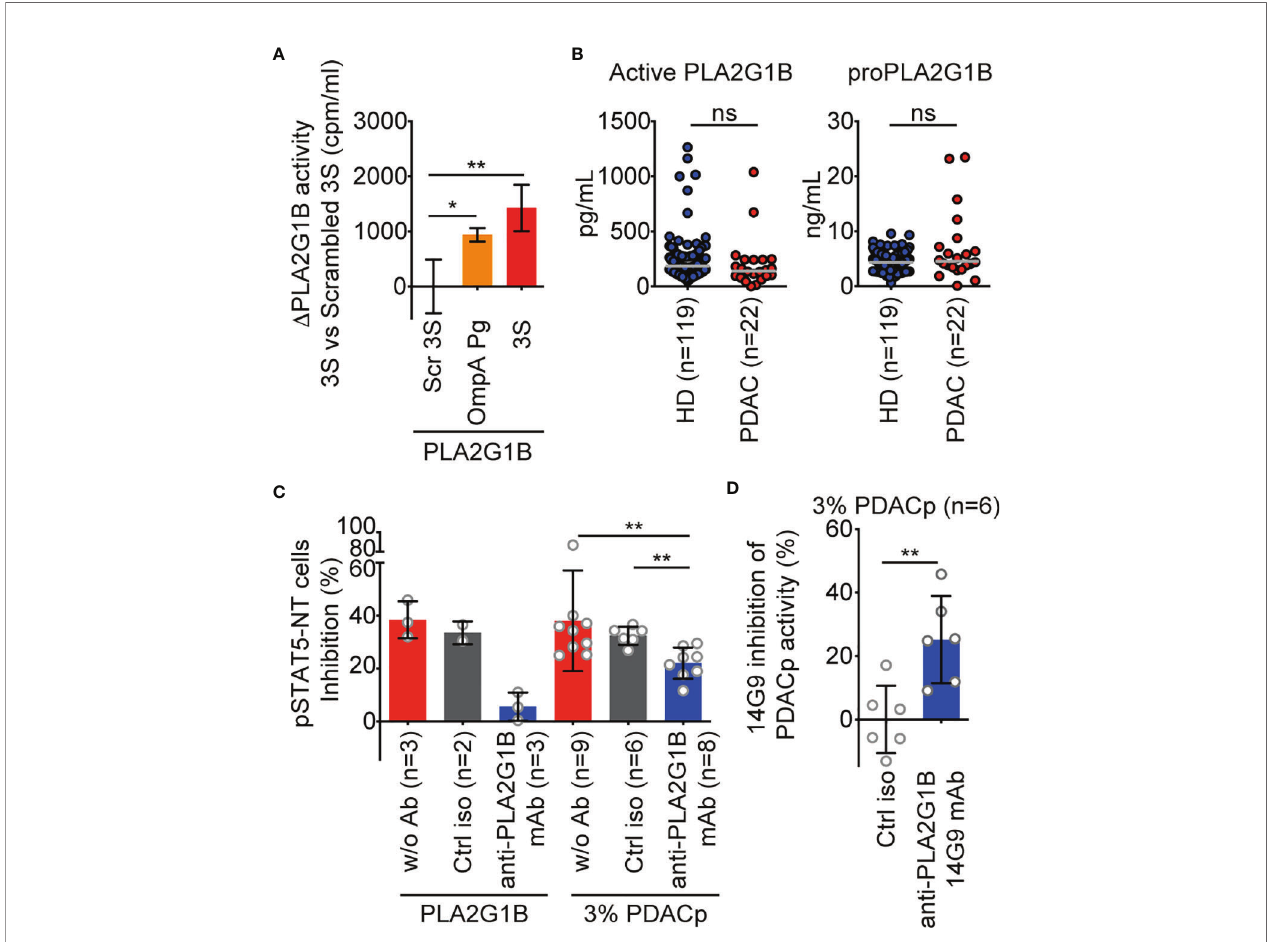
FIGURE 5 | PLA2G1B is involved in PDAC plasma inhibition of the CD4 T-cell pSTAT5-NT response. (A) A 3S-like peptide from P. gingivalis (OmpA Pg) increases PLA2G1B enzymatic activity. [3H]-AA-labeled Jurkat T cells were pretreated with 3S, OmpA Pg or scrambled 3S (Scr 3S) peptides (11µM) for 21 h and incubated alone or with PLA2G1B (200 nM). Results are shown as the mean ± SD of PLA2G1B activity with the 3S or OmpA Pg minus PLA2G1B activity with Scr 3S from one representative experiment of two with similar results. (B) ELISA quanti fi cation of active PLA2G1B and proPLA2G1B in plasma from HD and PDAC donors (the median is shown). (C) Anti-PLA2G1B mAb inhibits PLA2G1B activity in PDAC plasma. HD CD4 T cells from three donors were treated with PLA2G1B (75 nM), 3% of PDAC plasma (PDACp) alone (w/o Ab, n = 9 plasma samples), with control isotype (ctrl iso, 667 nM, n = 6 plasma samples) or anti-PLA2G1B mAb (14G9, 667 nM, n = 8 plasma samples) and the pSTAT5-NT cell response to IL-7 was analyzed by confocal microscopy. Results are shown as the mean ± SD of percentage of pSTAT5-NT cells inhibition. (D) Heterogeneity of anti-PLA2G1B mAb 14G9 inhibition of PLA2G1B activity in PDAC plasma. Results are shown as the mean ± SD of the percentage of inhibition of PDACp activity from six patients on pSTAT5-NT by 14G9 relative to that of control isotype-treated plasma. * p < 0.05, and ** p < 0.01, by two-way ANOVA with Tukey ’ s correction for multiple comparisons for A, by the Mann-Whitney test for B and D, and by the Kruskal-Wallis test followed by the Mann-Whitney test, with p-values adjusted for multiple comparisons between groups, for C. ns, non signi fi